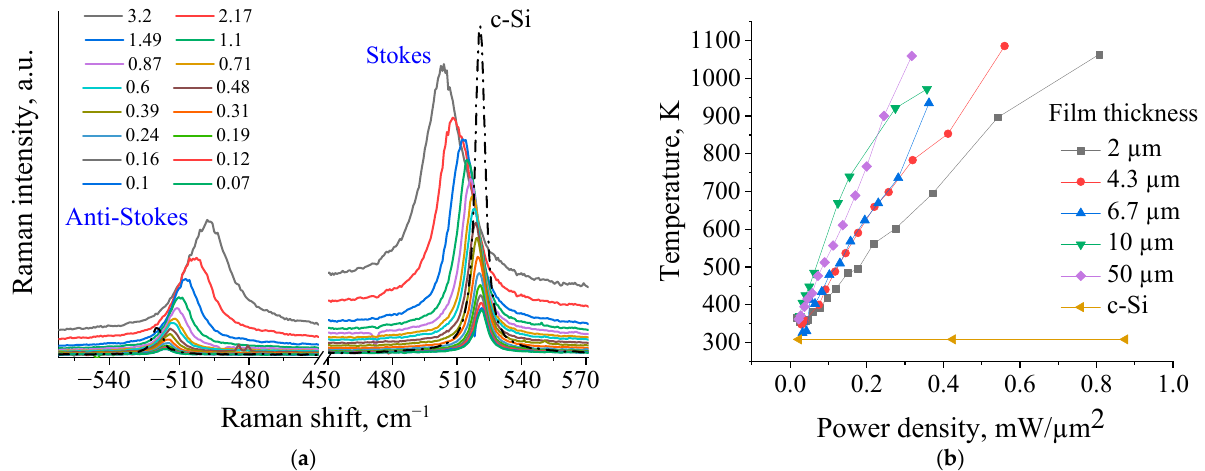
Figure 4. ( a ) Measured Stokes and ant-Stokes Raman spectra at various laser powers and ( b ) corresponding laser induced temperature rises in the Si NP films with various thicknesses and a bulk crystalline silicon substrate (c-Si) versus laser power densities.